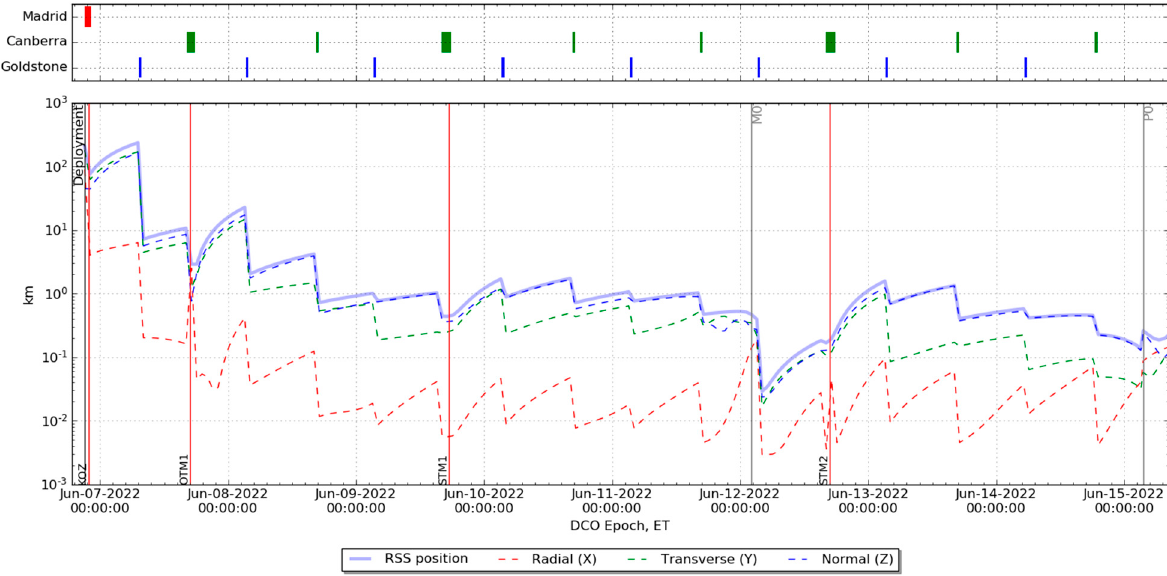
Figure 14. Position uncertainty evolution (3-sigma) during REV0, in the Earth-centered RTN frame.